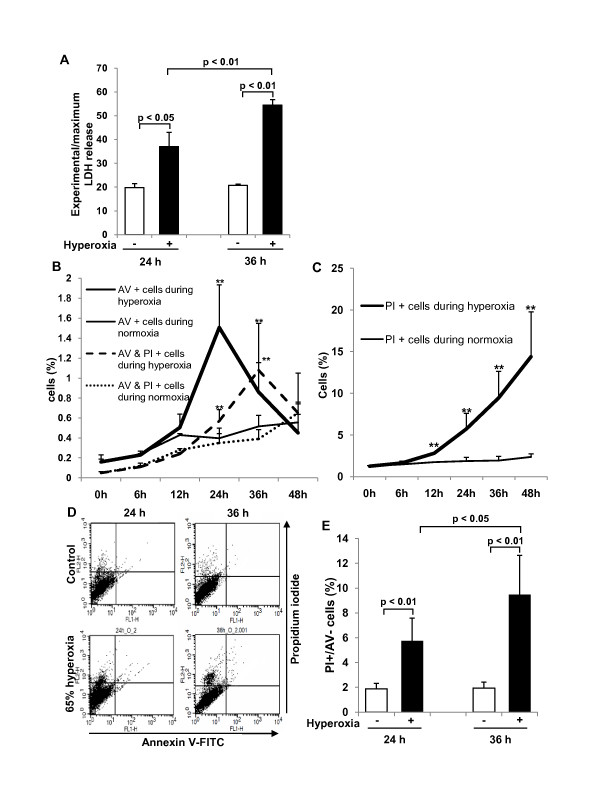
Effect of 65%-hyperoxia on fetal type II cell necrosis. (A) Graphical depiction showing LDH-release expressed as experimental minus background LDH-release divided by maximum LDH-release in hyperoxic and normoxic cells. The results are represented as the mean ± SD from 3 different experiments. (B) Graphical depiction showing the changes in the selective AV-positive cells and the dual positive (AV-positive and PI-positive) cells during normoxia and 65%-hyperoxia for 48 h. The results are represented as the mean ± SD from 3 different experiments. **; p < 0.01. (C) Graphical depiction showing the changes in the selective PI-positive cells during normoxia and 65%-hyperoxia for 48 h. The results are represented as the mean ± SD from 3 different experiments. **; p < 0.01. (D) Graphical depiction showing the distribution of necrotic cells (PI-positive and AV-negative) under normoxic and hyperoxic conditions. (E) Graphical depiction showing cellular necrosis (PI-positive and AV-negative) as a percentage of the total cell number in normoxic and hyperoxic cells. The results are represented as the mean ± SD from 6 different experiments.